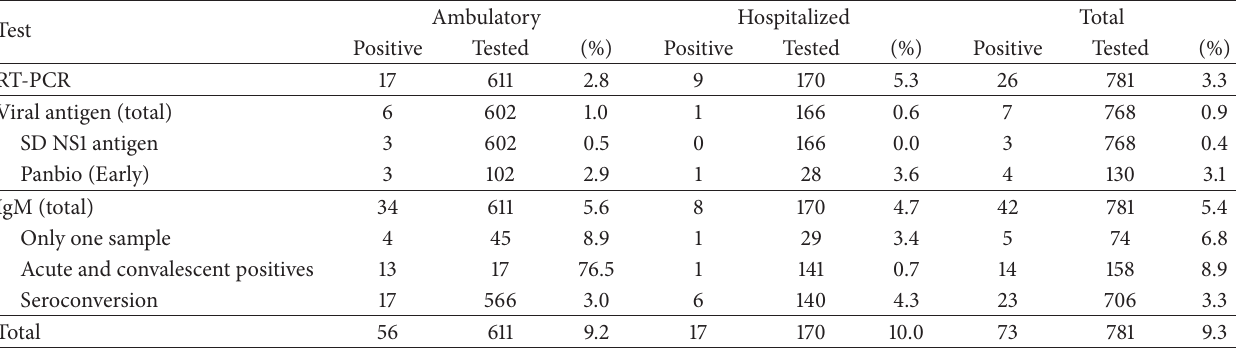
Table 2: Dengue diagnostic results for ambulatory and hospitalized patients, Medellin, Colombia, March